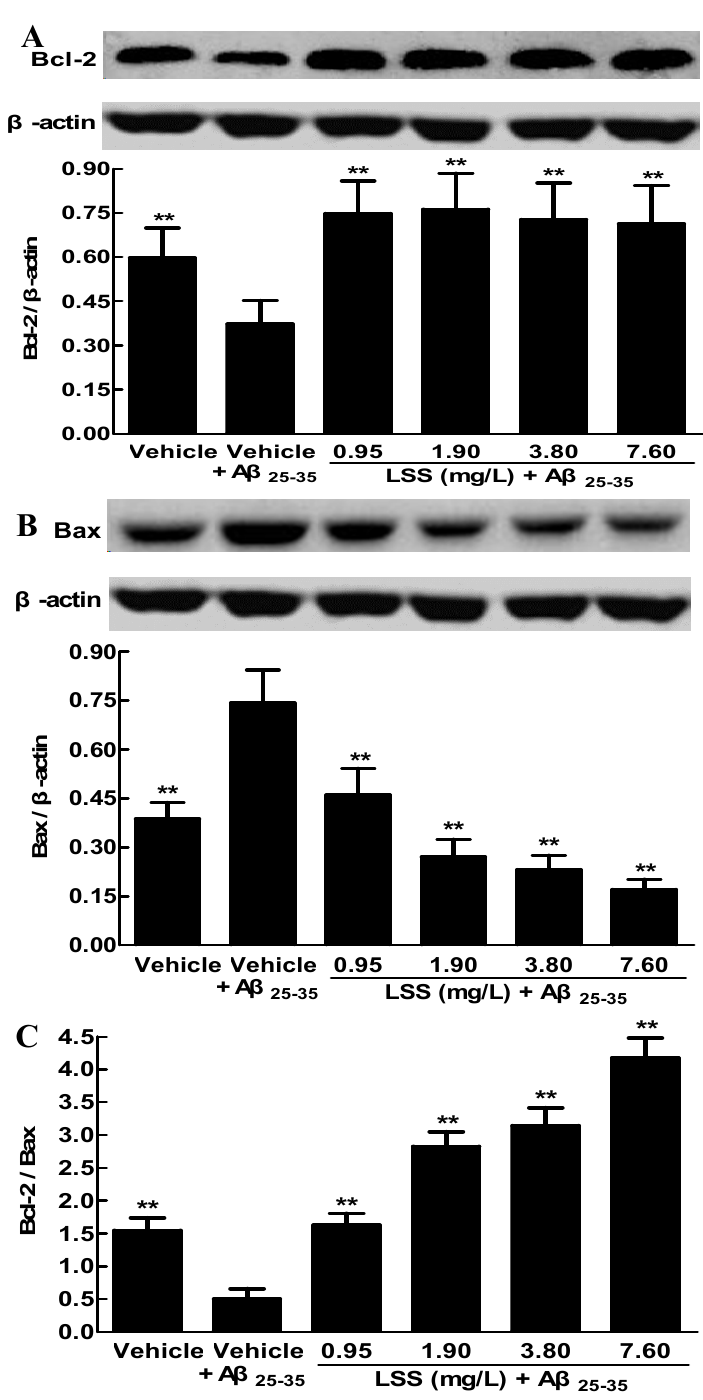
Figure 5. Effects of LSS on the protein expressions of Bcl ‐ 2 ( A ), Bax ( B ), and the ratio of Bcl ‐ 2/Bax ( C ) in PC12 cells with or without exposure to 20 μ mol/L A β 25 ‐ 35 for 12 h. The results are representative of at least three independent experiments run in triplicate and expressed as mean ± SD. ** p < 0.01 vs. the cells treated with A β 25 ‐ 35 and vehicle.